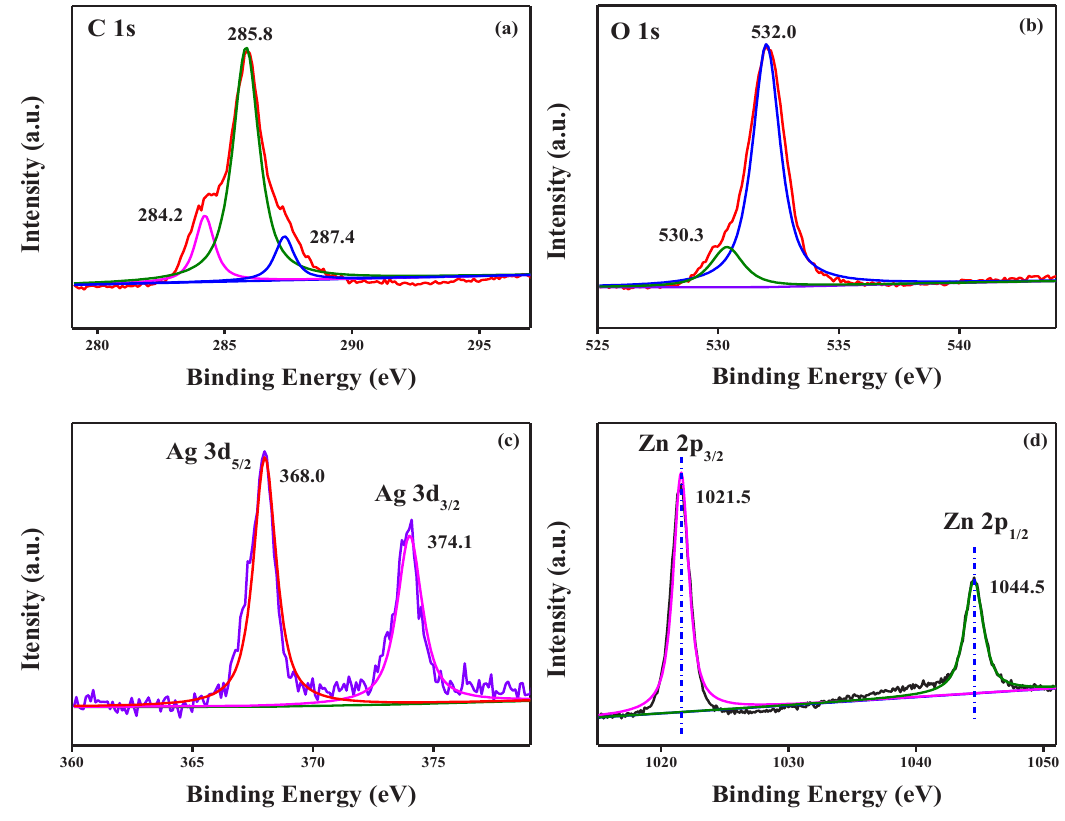
Figure 4: XPS of ZAC-12, C1s (a), O1s (b), Ag 3d (c) and Zn 2p (d).